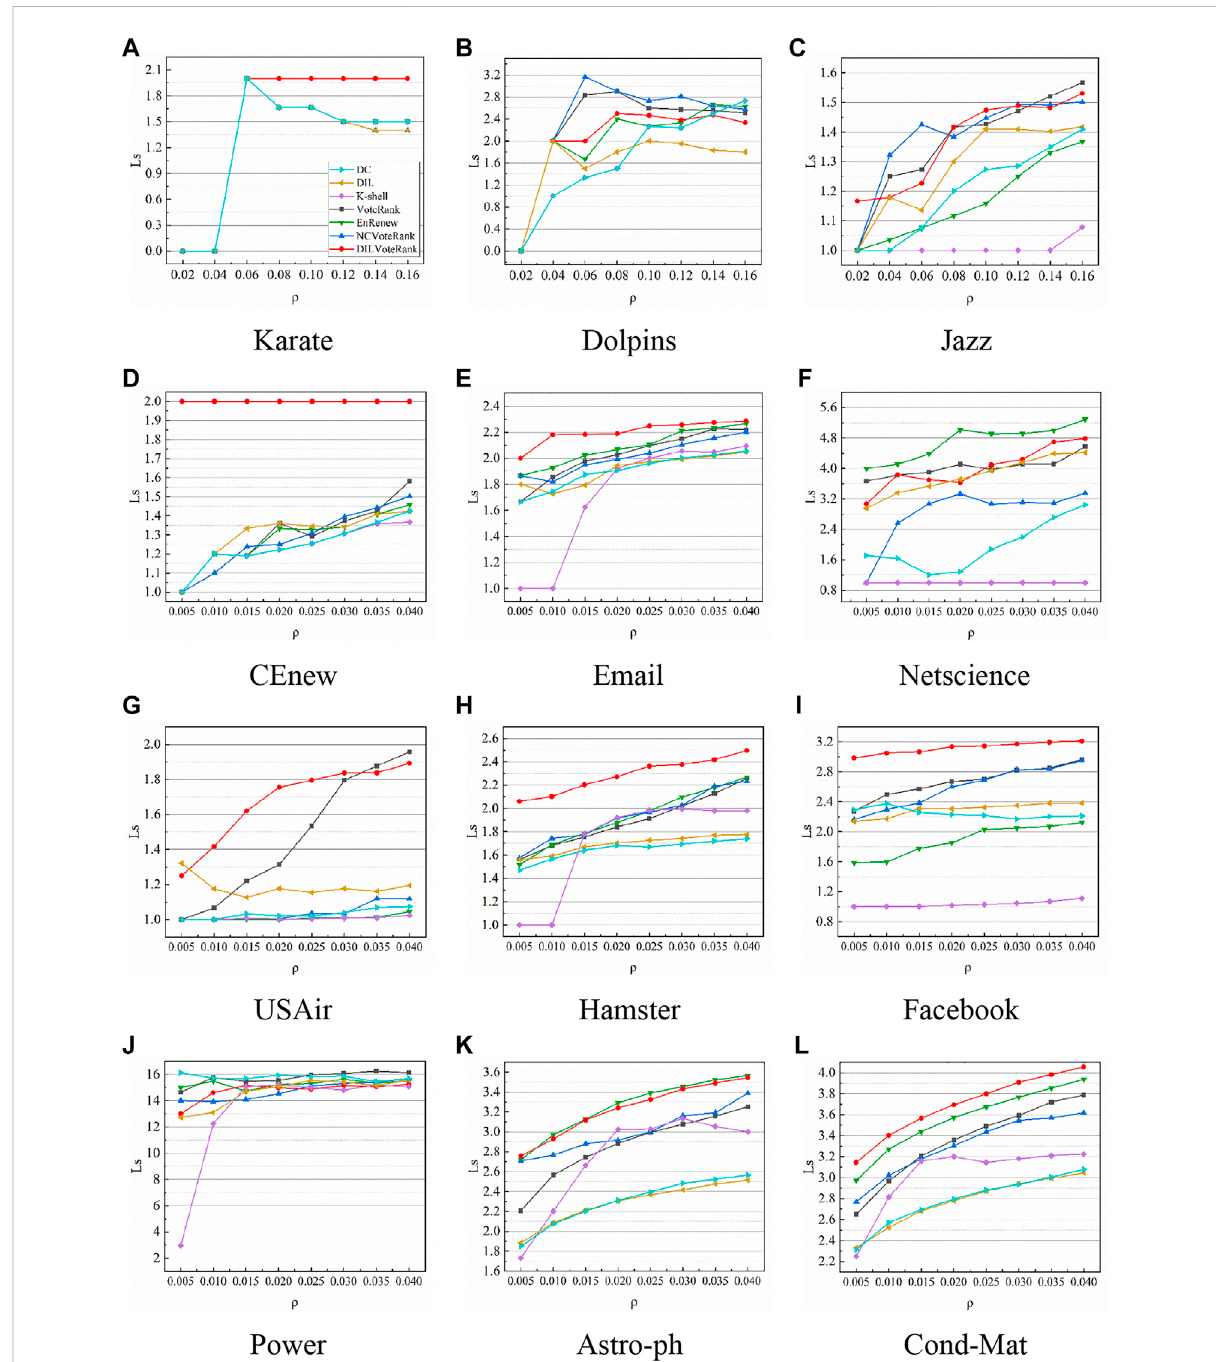
FIGURE 6 Theshortestpathsbetweenspreadersselectedbydifferentalgorithms,withdifferentinitialproportions.Subgraphs (A – L) respectivelyrepresent the experimental results of 12 datasets in Table